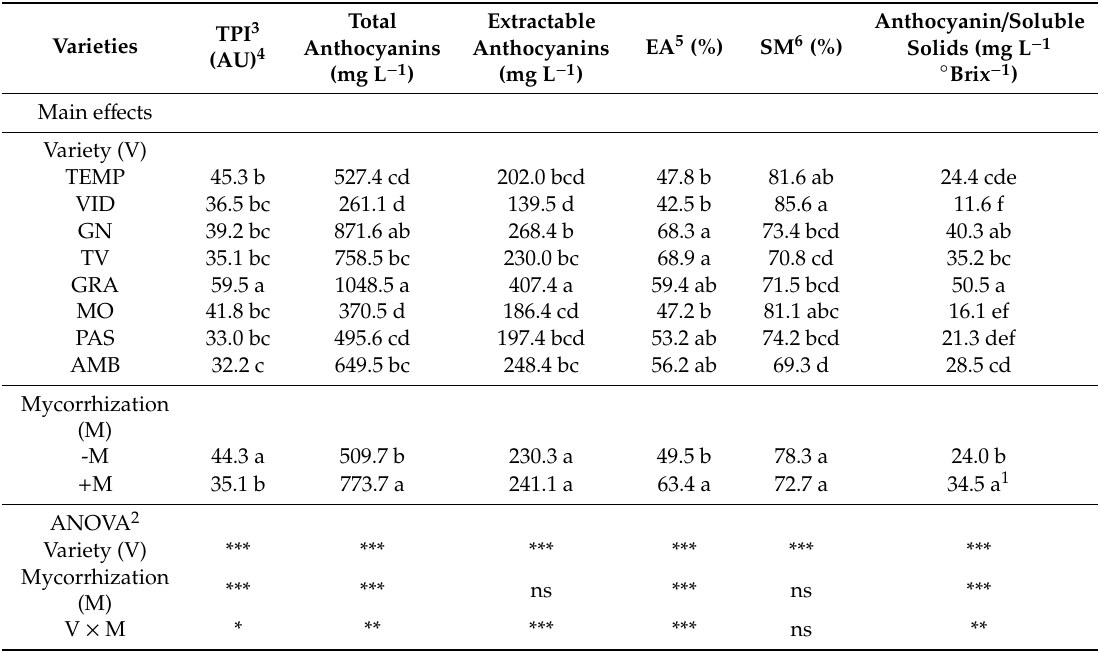
Table 5. Main e ff ects and their interaction on phenolic composition from fruit-bearing cuttings of ancient grapevine varieties inoculated with arbuscular mycorrhizal fungi ( + M) or non-inoculated (-M). The variety labels can be found in Table